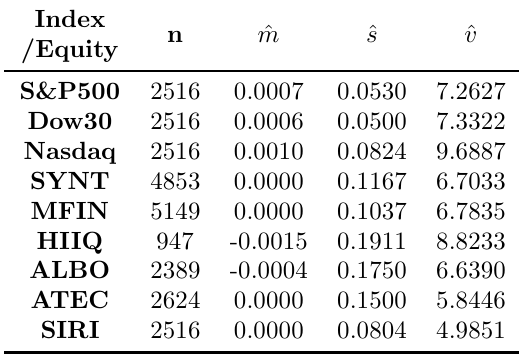
MLE for Generalized double Lomax